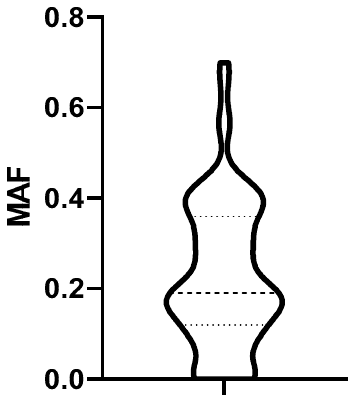
Figure 4. Distribution of MAF values. Dashed lines represent the median, the 25% and the 75% percentile. MAF: multidrug resistance activity factor.